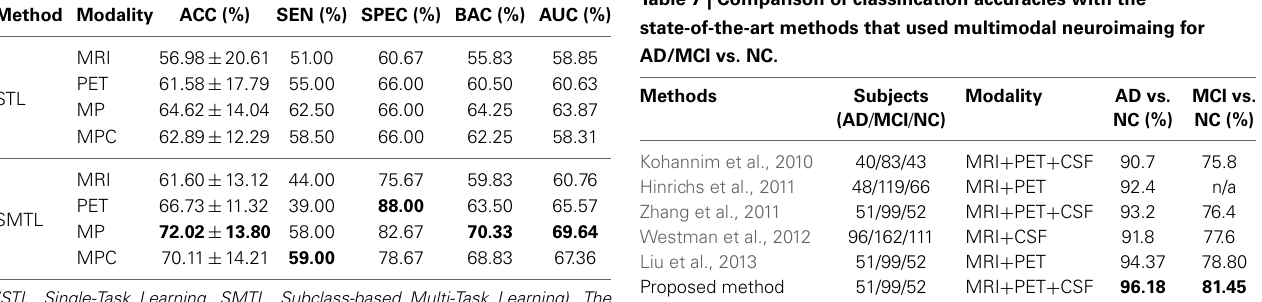
(STL, Single-Task Learning, SMTL, Subclass-based Multi-Task Learning). The boldface denotes the best performance in each metric. The boldface denotes the best performance in each classification task.